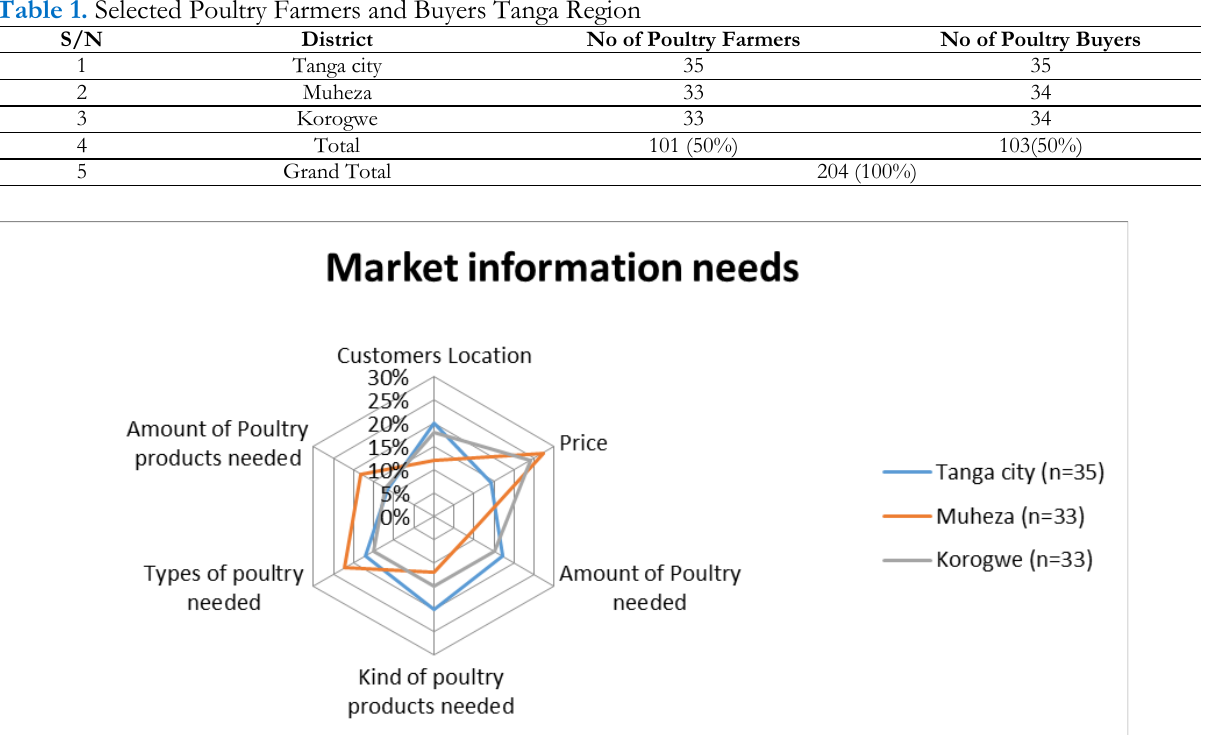
Figure 2. Description of poultry farmer’s market information requirements,